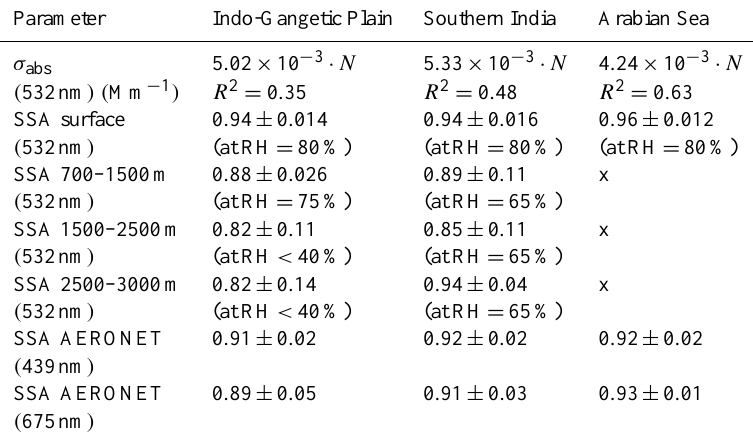
Table 3. Coefficients used to describe the relationship between particle absorption ( σ abs ) and particle number concentration N for different source regions. Also shown is the mean SSA for various height levels used to calculate the lidar-derived absorption coefficients as well as the AERONET SSA at ambient relative